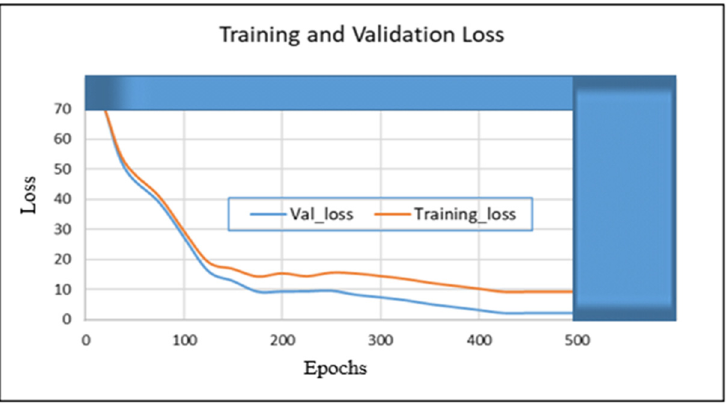
Figure 8. The proposed TSDCNN overall performance losses on vehicle matching rates across non-overlapping cameras with multiple angle views using the VeRi776 dataset.